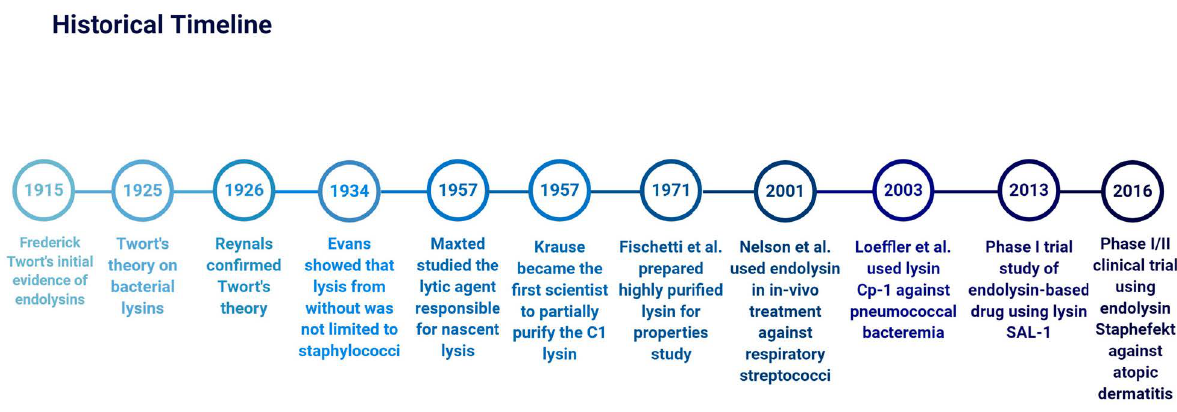
Figure 1. Timeline showing a brief history of endolysin research